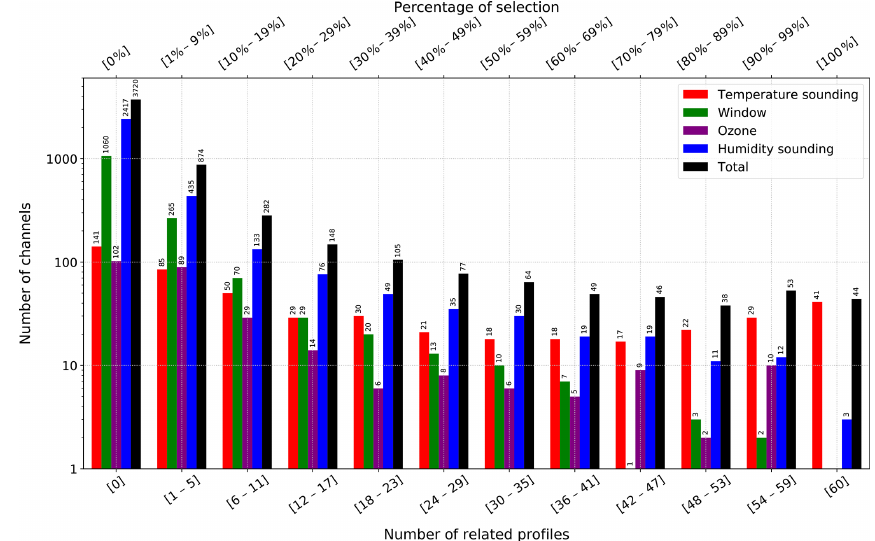
Figure 9. Percentage of the number of channels selected (up to 400 channels) on the subset of 60 atmospheric profiles divided by spectral group to temperature sounding (in red), window (in green), ozone (in purple), humidity sounding (in blue) and total (in black).